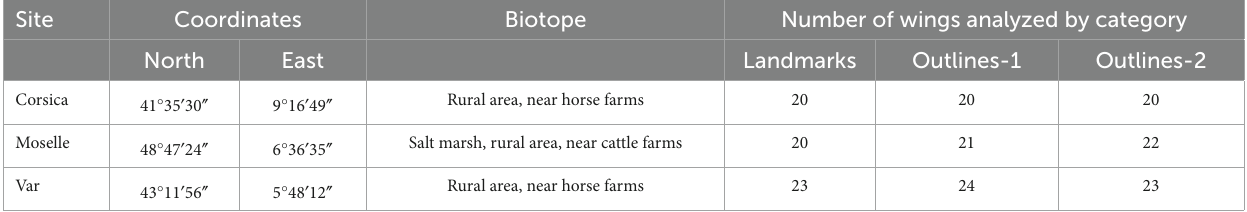
TABLE 1 Description of the sampling stations and number of Culicoides circumscriptus wings analyzed by site for the geometric morphometrics